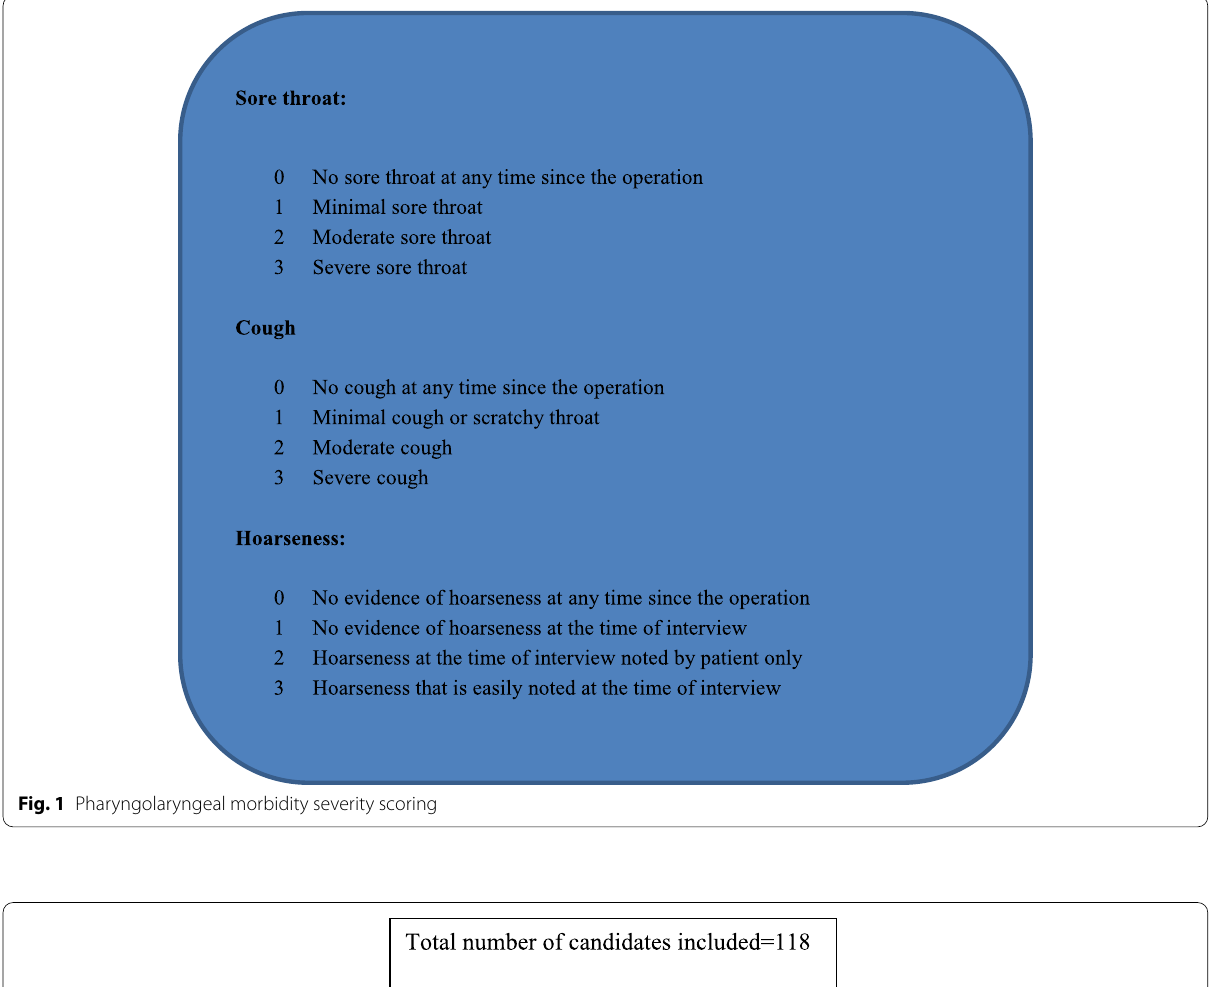
Fig. 1 Pharyngolaryngeal morbidity severity scoring